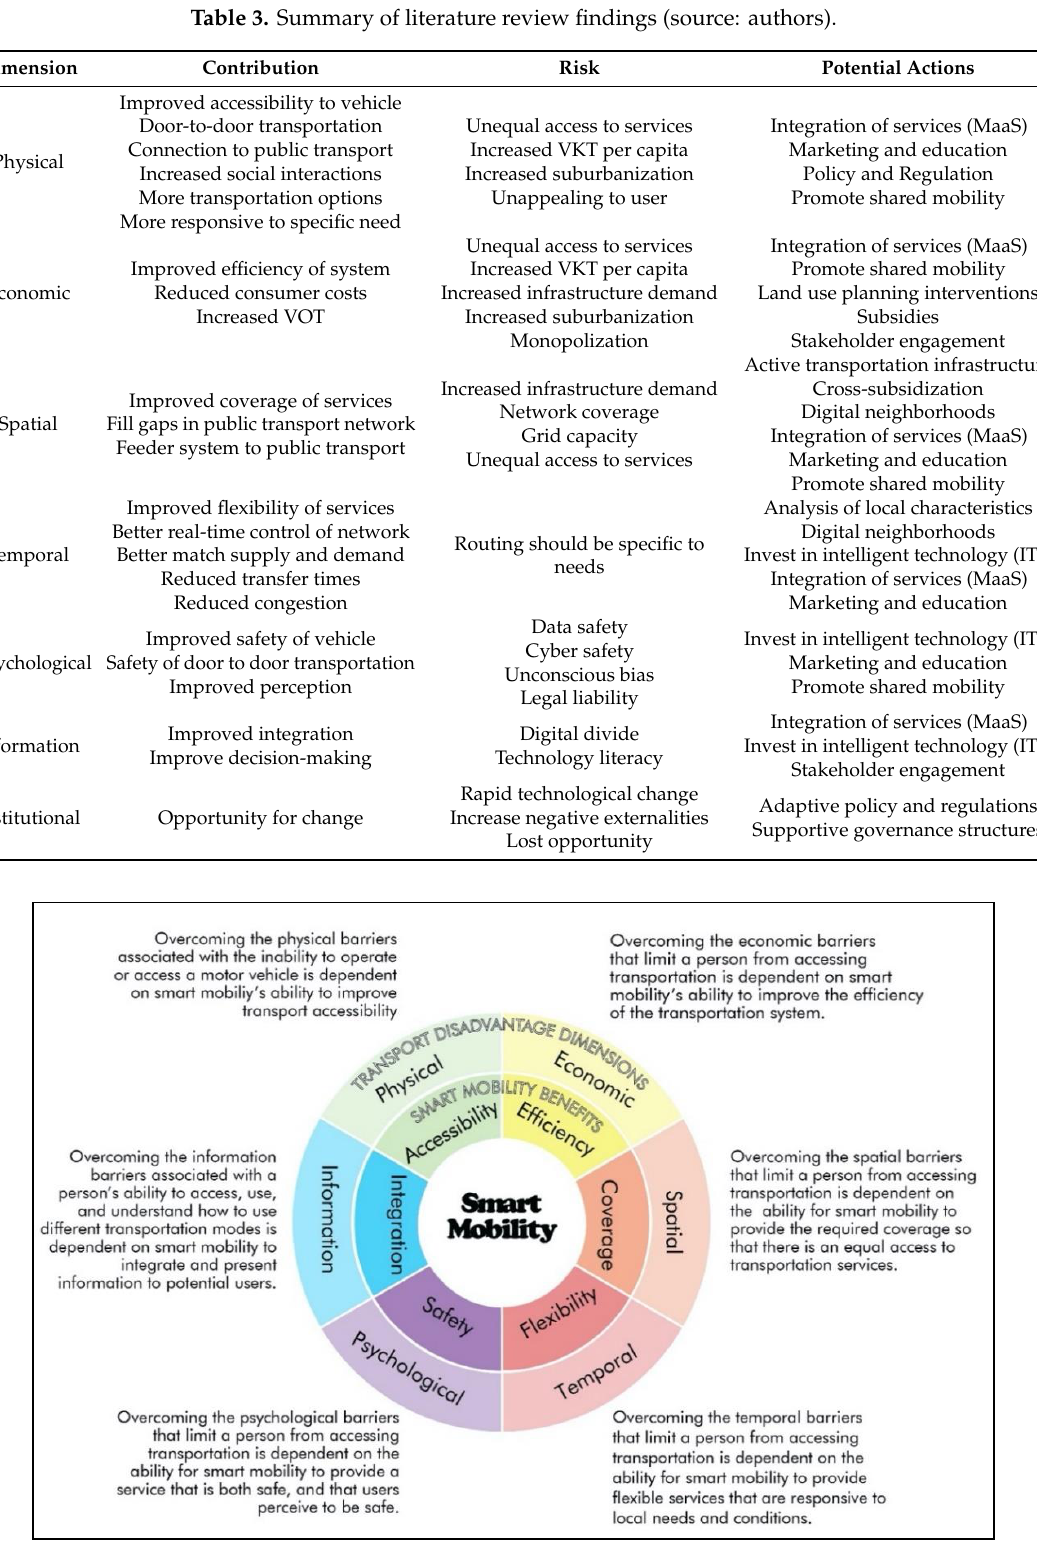
Figure 4. Conceptual framework of smart mobility and transportation disadvantage (source: authors).